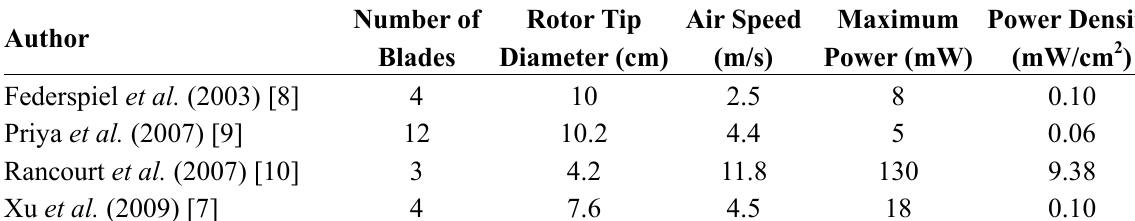
Table 2. Summary of current small-size wind